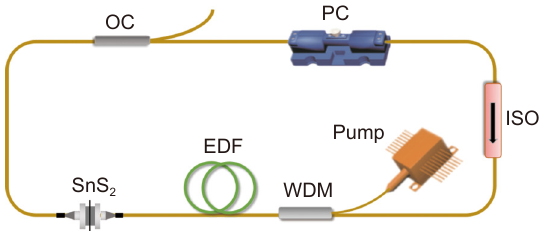
Fig. 2 | The simplified representation of QSFL based on SnS 2 .